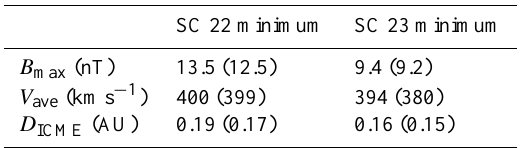
Table 3. Averages of ICMEs during the SC 22 and SC 23 minima. Median values are given in